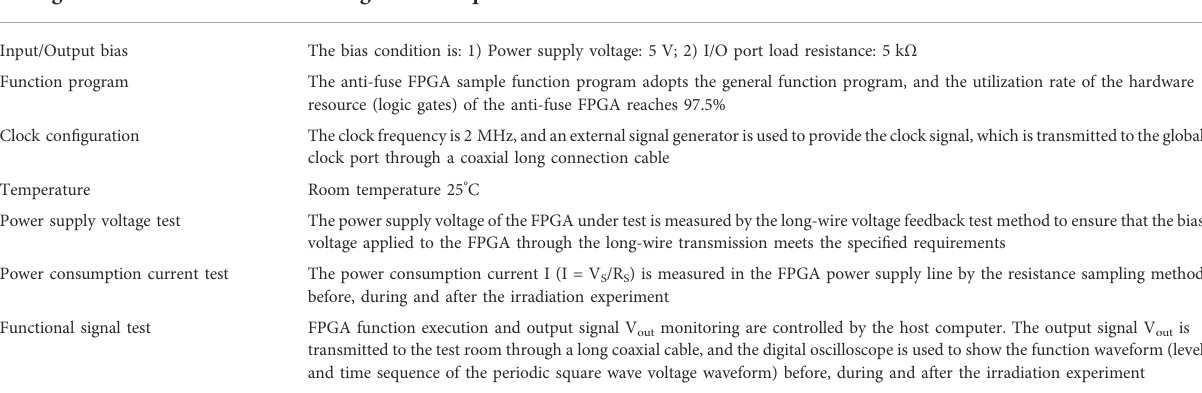
TABLE 2 Experimental con fi